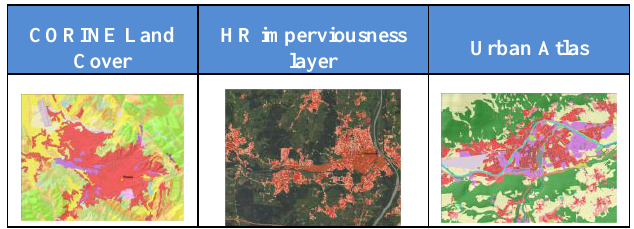
Figure 10: LACO-Wiki will address the validation of European land monitoring